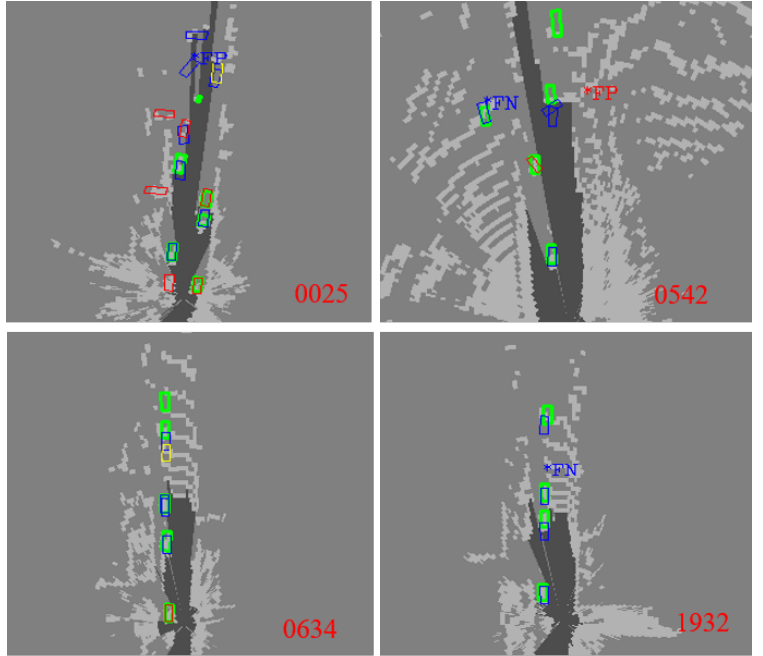
Figure 9. Judgment results of perception effectiveness: the judgment is correct. The judgment and verification are valid after matching and verifying with the ground